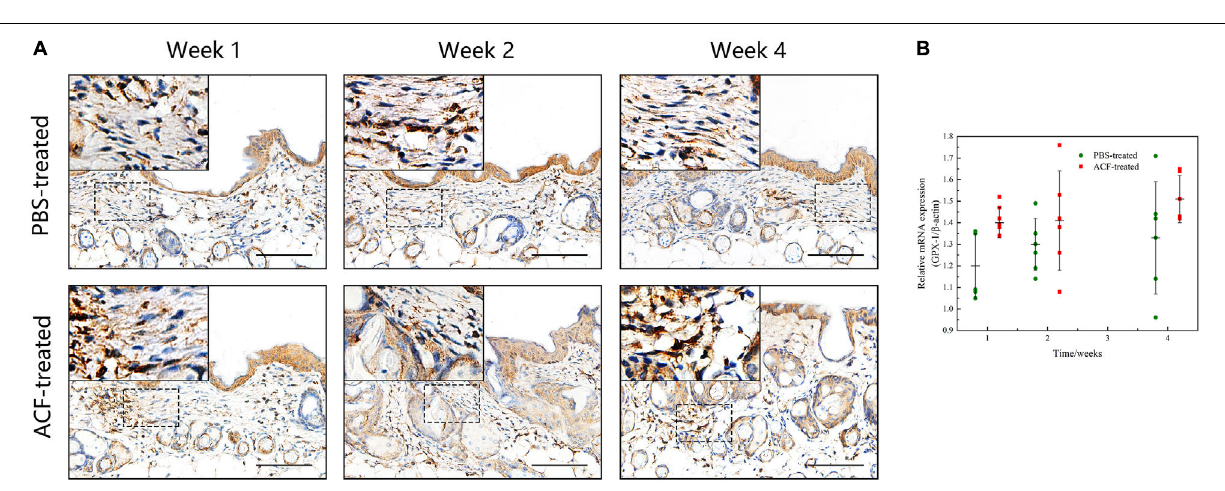
FIGURE 14 | The expression of GPX-1 of mouse skin samples of ACF-treated group and control group. (A) The expression of antioxidant enzyme GPX-1 was detected in both the ACF-treated and control groups at each time point. (B) Quantitative reverse transcription PCR analysis of the GPX-1 expression in the dermis of both groups. The higher expression of GPX-1 was detected in the ACF-treated group than that in control groups at week 1. P (week 1) = 0.003, F (week 1) = 0.105; P (week 2) = 0.303, F (week 2) = 0.303; P (week 4) = 0.145, F (week 4) = 0.228. Scale bar = 100 µ